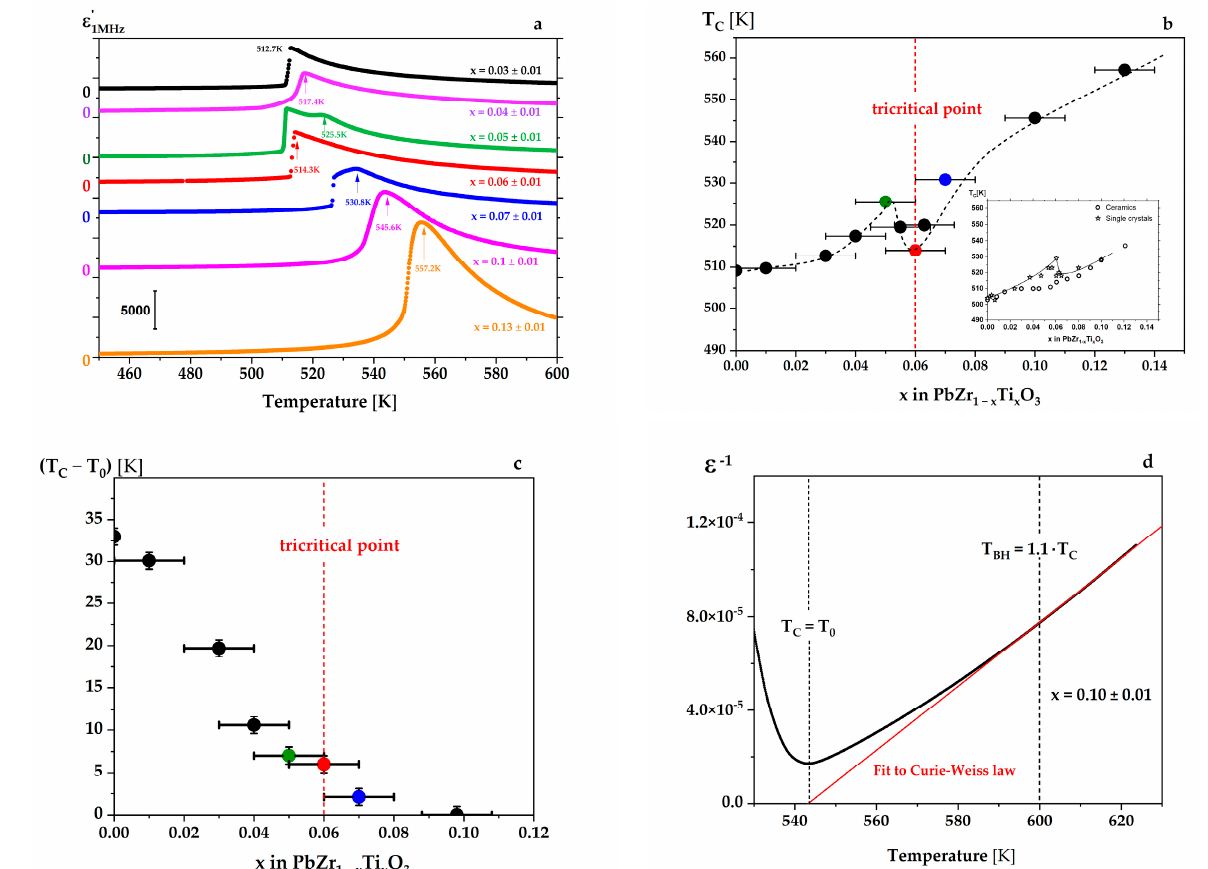
Figure 1. ( a ) Permittivity as a function of temperature on heating for PZT single crystals with different Ti contents. On cooling, the dependences are very similar, undergoing 1.5 K thermal hysteresis only. Note the complex variation of ε ′ (T) near the transition point for compositions with x ⁓ 0.06 ± 0.01. ( b ) The compositional variation of T C is defined as that at which the domain structure disappears during the transition from the rhombohedral to cubic phase (see arrows in ( a )). The T C (x) dependence (dashed line is a guide for the eyes) is similar to that shown in the inset. The inset represents changes of T C (x) for ceramics and single crystals, with a local extremum at T C for the single crystal at the tricritical point for x = 0.06 ± 0.01 observed by Whatmore et al. (redrawn from [20]) and denoted by the red dashed line in ( b ). Points for x = 0 and 0.01were taken from [35,36]. ( c ) The compositional variation of the difference (T C − T 0 ) in PbZr 1-x Ti x O 3 single crystals. (T C − T 0 ) diminishes towards zero at around x = 0.10, as would be expected for a second-order phase transition. ( d ) The Curie-Weiss law obeyed for crystals with x = 0.10, for which T c = T 0 is characteristic of a continuous (second order) phase transition.